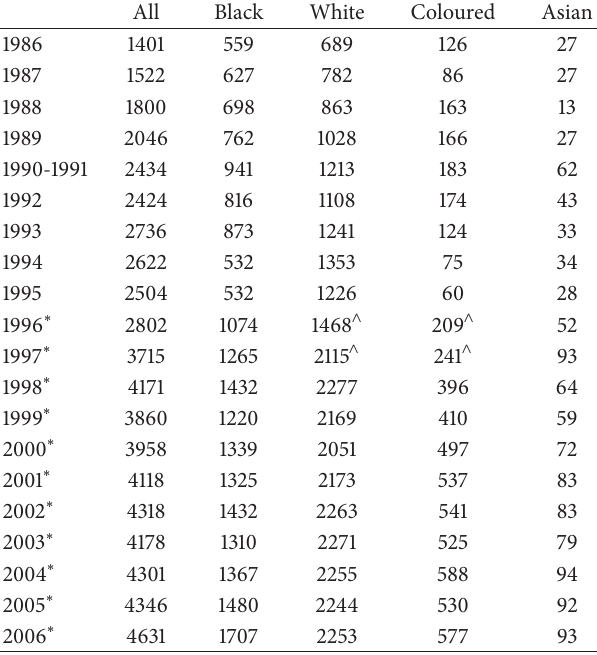
Table 1: The number of prostate cancer cases reported to the South AfricanpathologybasedNationalCancerRegistry,years1986–2006, by population